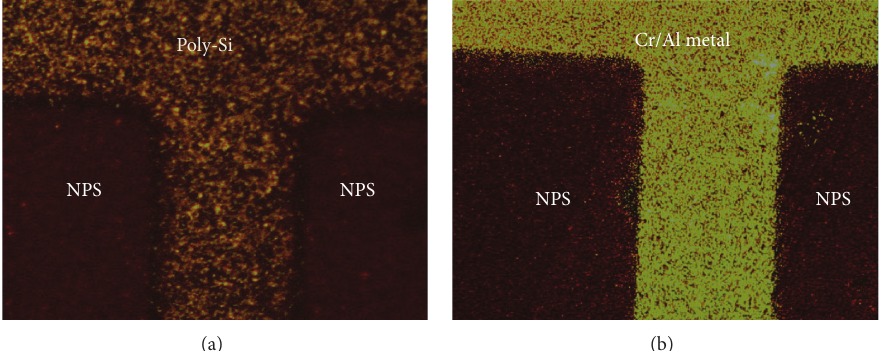
Figure 3: The local images of the formed trench structures on NPS (a) before and (b) after metal contacts, observed by an optical microscope.